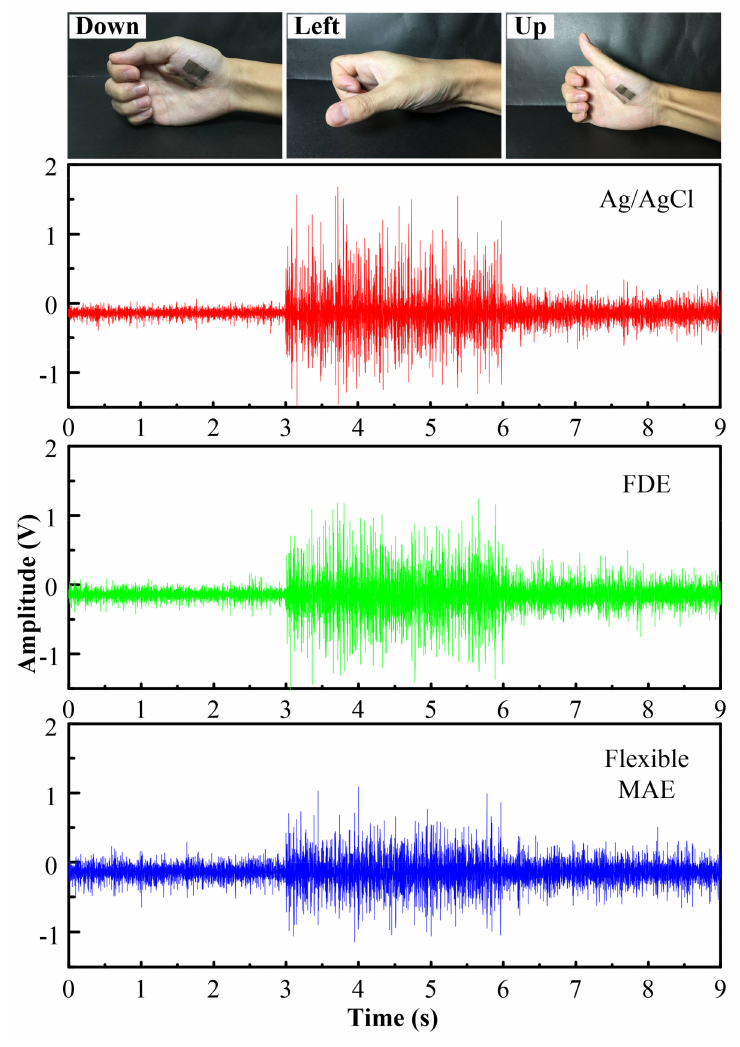
Figure 6. EMG signals of three thumb motions recorded by Ag/AgCl electrode, FDE and flexible